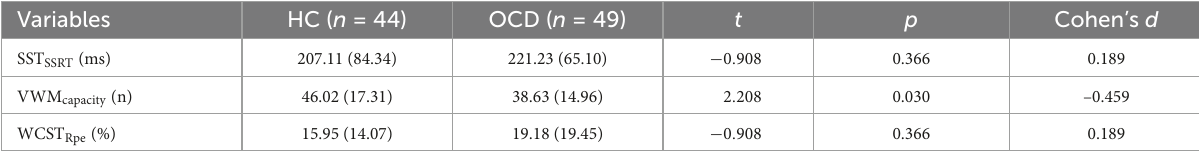
TABLE 2 Executive function indicators of the two groups.